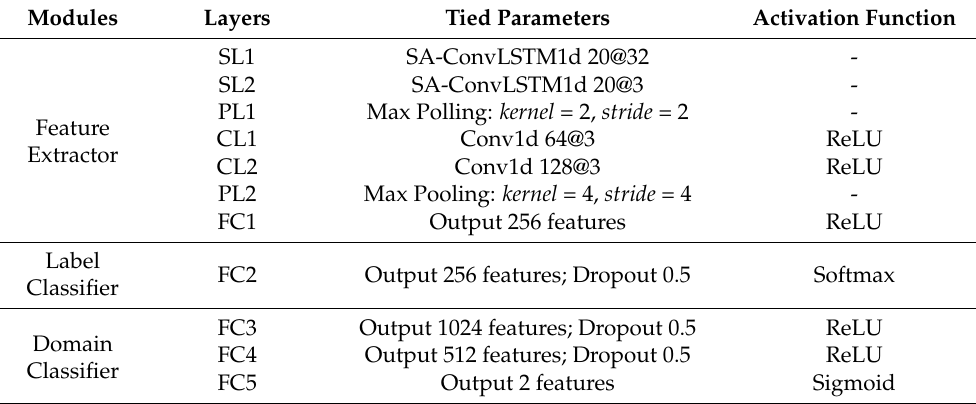
Table 1. Architecture and parameter settings for the